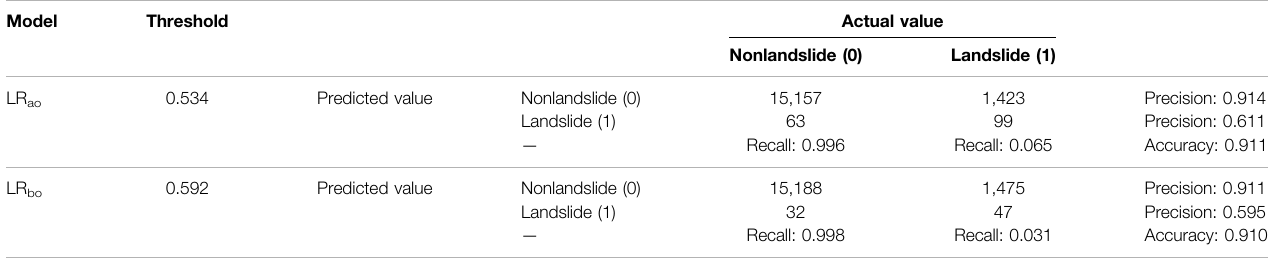
TABLE 6 | Confusion matrix between observed and predicted values under optimal threshold conditions for LR ao and LR bo models.